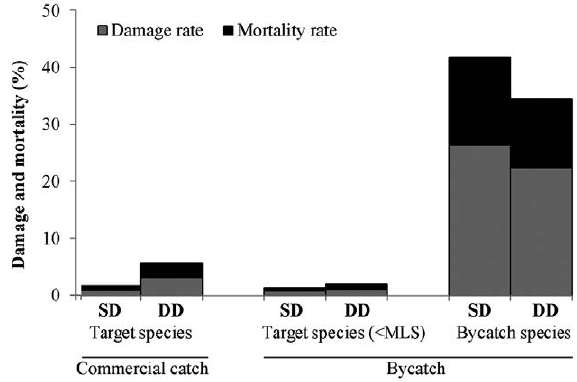
Fig. 5. – Comparison of the damage and mortality rates in the catches of the target species ( Spisula solida , Chamelea gallina and Donax trunculus ) and bycatch (target species <MLS and bycatch species) using SDredge and